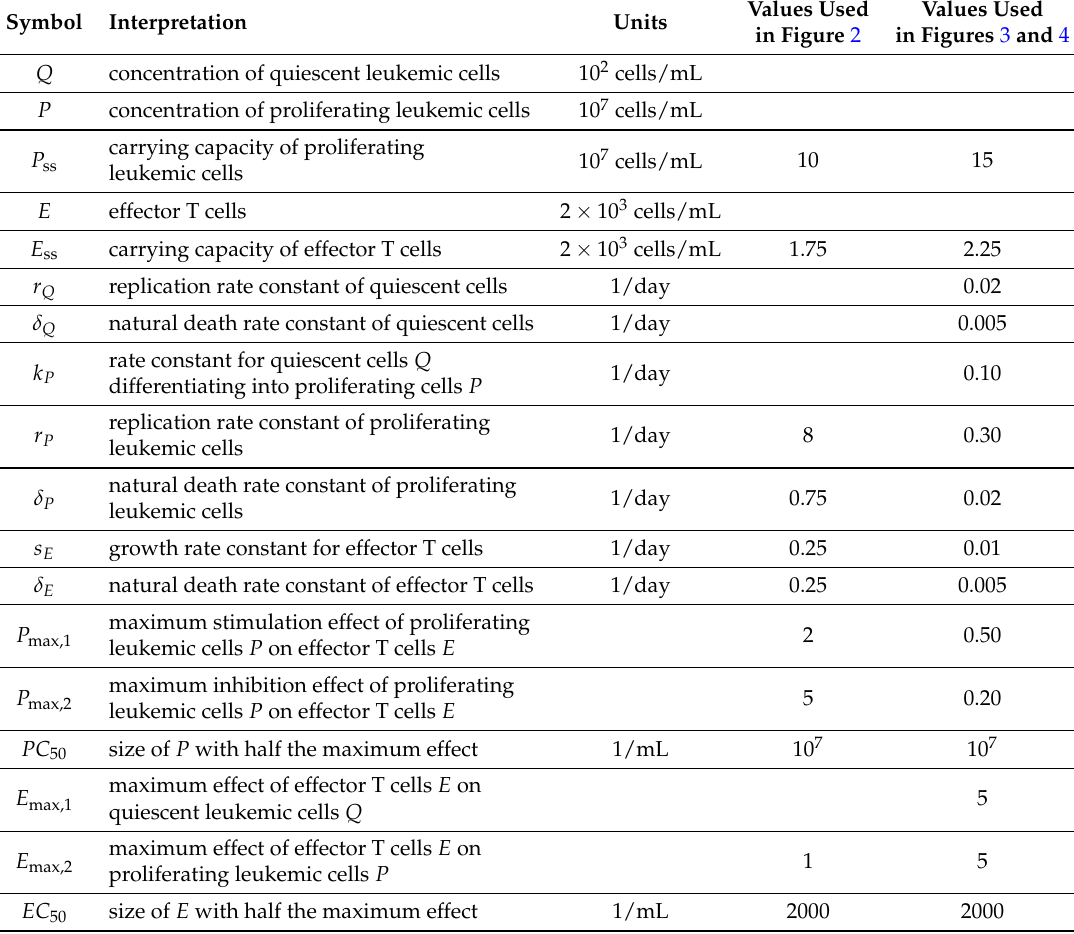
Table 1. States and parameters for the dynamical